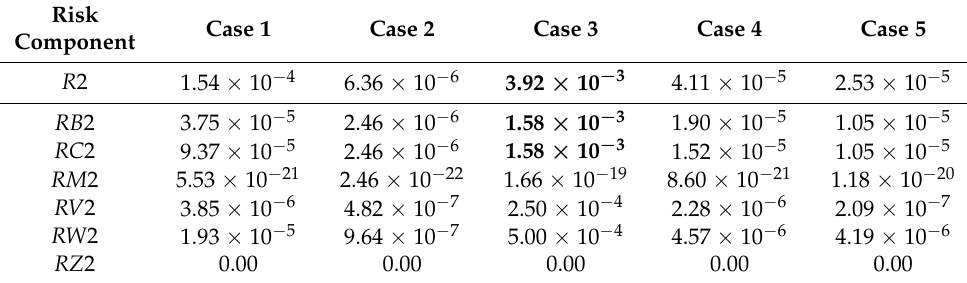
Table 8. Result of Risk Value of Loss of Service to the Public ( R